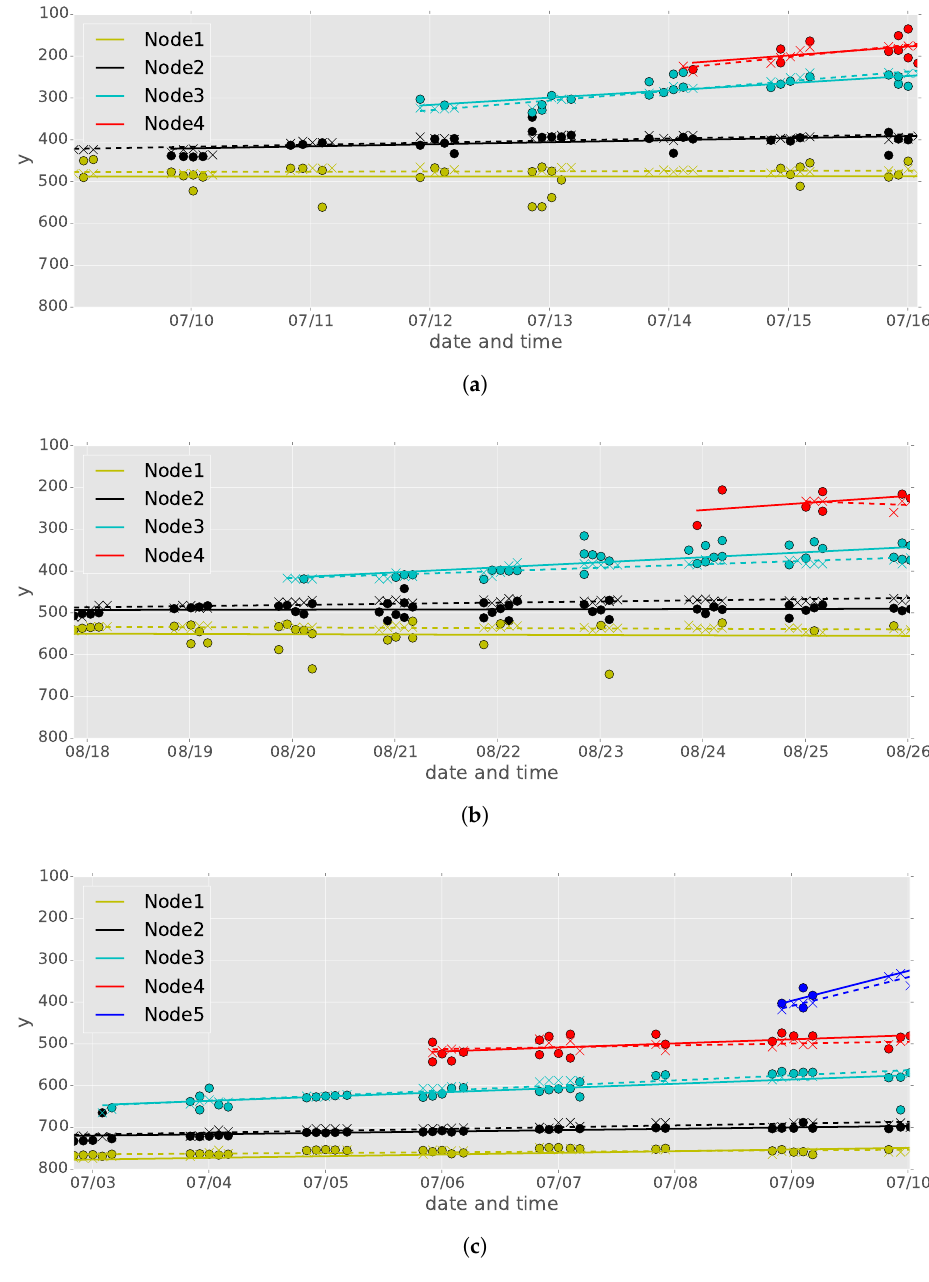
Figure 6. Result of node order estimation of ( a ) seedling A, ( b ) seedling B, and ( c ) seedling C. The horizontal and vertical axes represent the image capturing date and time and y coordinate value of the detected node, respectively. ◦ and × represent the detected and observed nodes, and solid and dashed lines represent the node lines calculated on the basis of detected and observed nodes, respectively. Points and lines with the same color belong to the same node